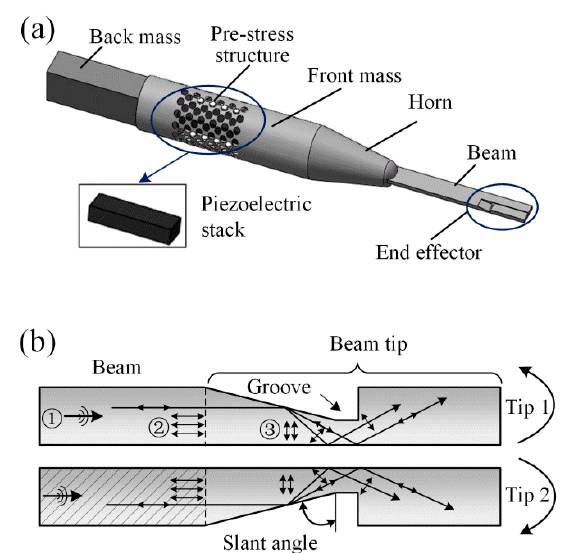
Figure 1. The schematic illustration of the as-designed scissoring actuator with (a) assembly drawing and (b) detailed view of vibration wave propagation at converter, ① input longitudinal elastic wave, ② propagating wave and ③ mode conversion.